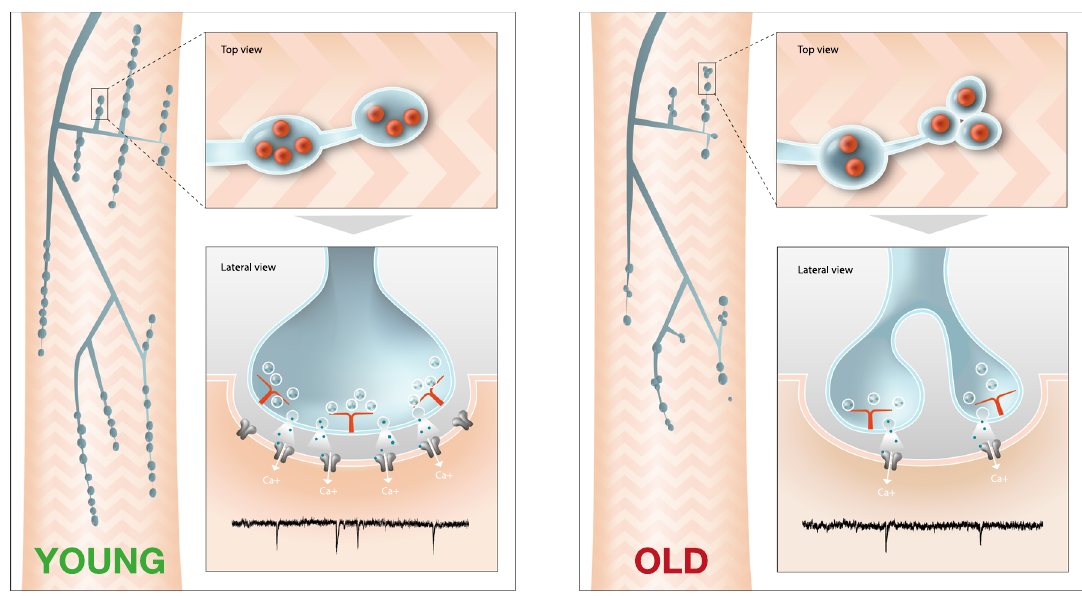
Fig. 5 Model of NMJ synaptic structural changes in response to miniature event decline during ageing. Miniature event frequency declines during ageing. In response, synaptic bouton diameters decrease and there is an increase in the number of small boutons with only a single active zone. All of these observations are consistent with young multiple active zone boutons fragmenting into smaller single active zone boutons as animals age. Reducing miniature events can accelerate this bouton fragmentation process in young animals while increasing miniature event frequency can delay synapse fragmentation in ageing